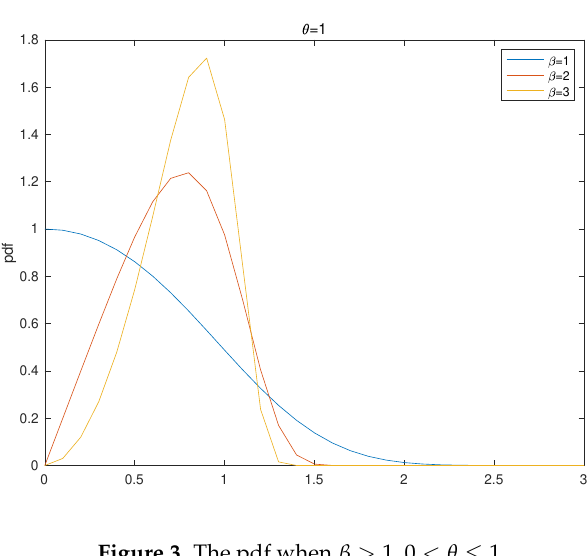
Figure 3. The pdf when β > 1, 0 < θ ≤ 1.